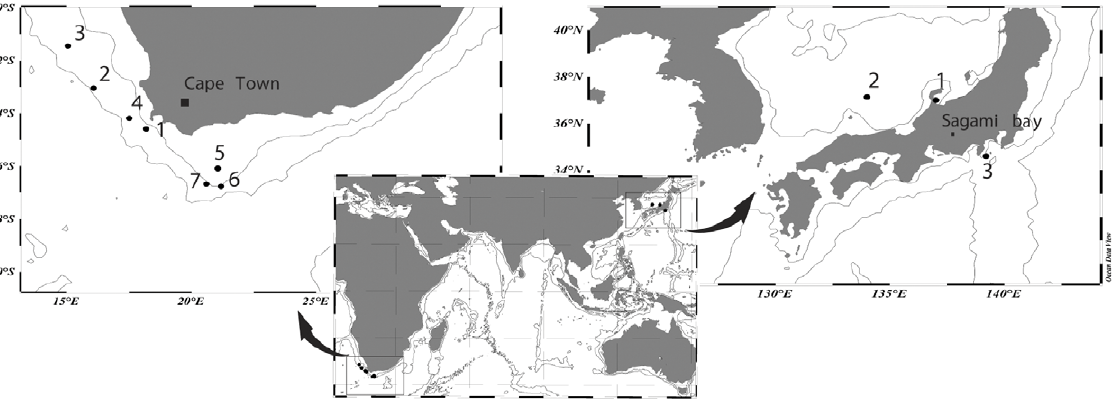
Figure 1. Geographic locations of the samples analyzed for this study. Collections of C. sinicus were made in three locations to the West and East of Japan; C. agulhensis was collected to the south and west of South Africa. Numbers correspond to stations listed in Table 1. Populations are represented by stations 1, 2, 3 and 4 for Benguela and stations 5, 6 and 7 for Agulhas (left panel); stations 1 and 2 for West Japan and station 3 for East Japan (right panel).